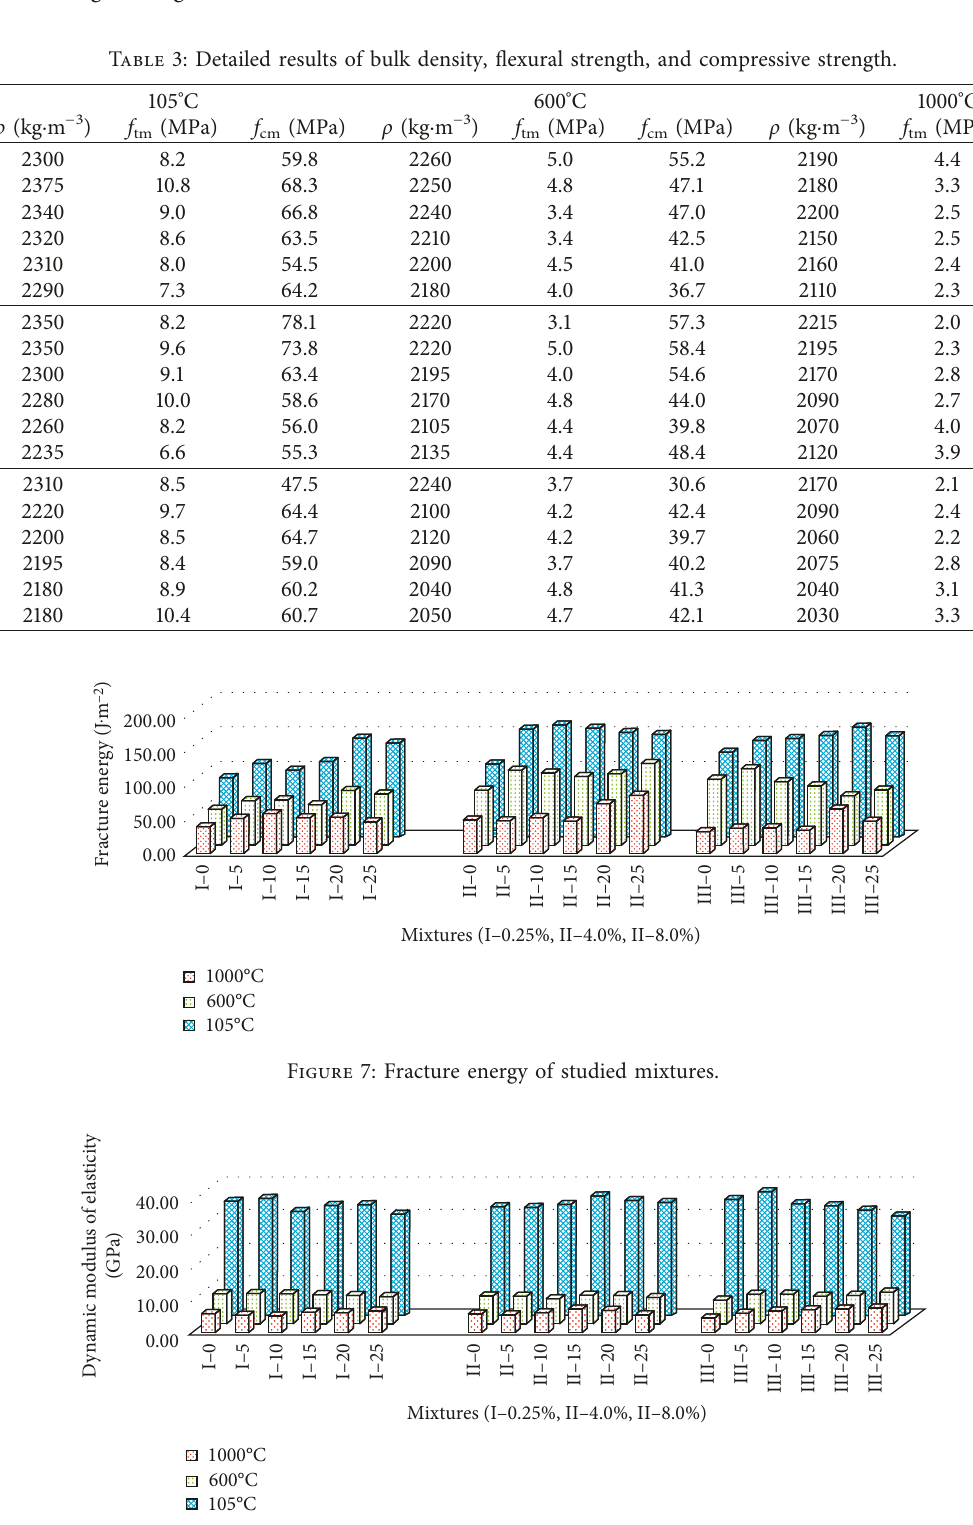
Figure 8: Dynamic modulus of elasticity of studied